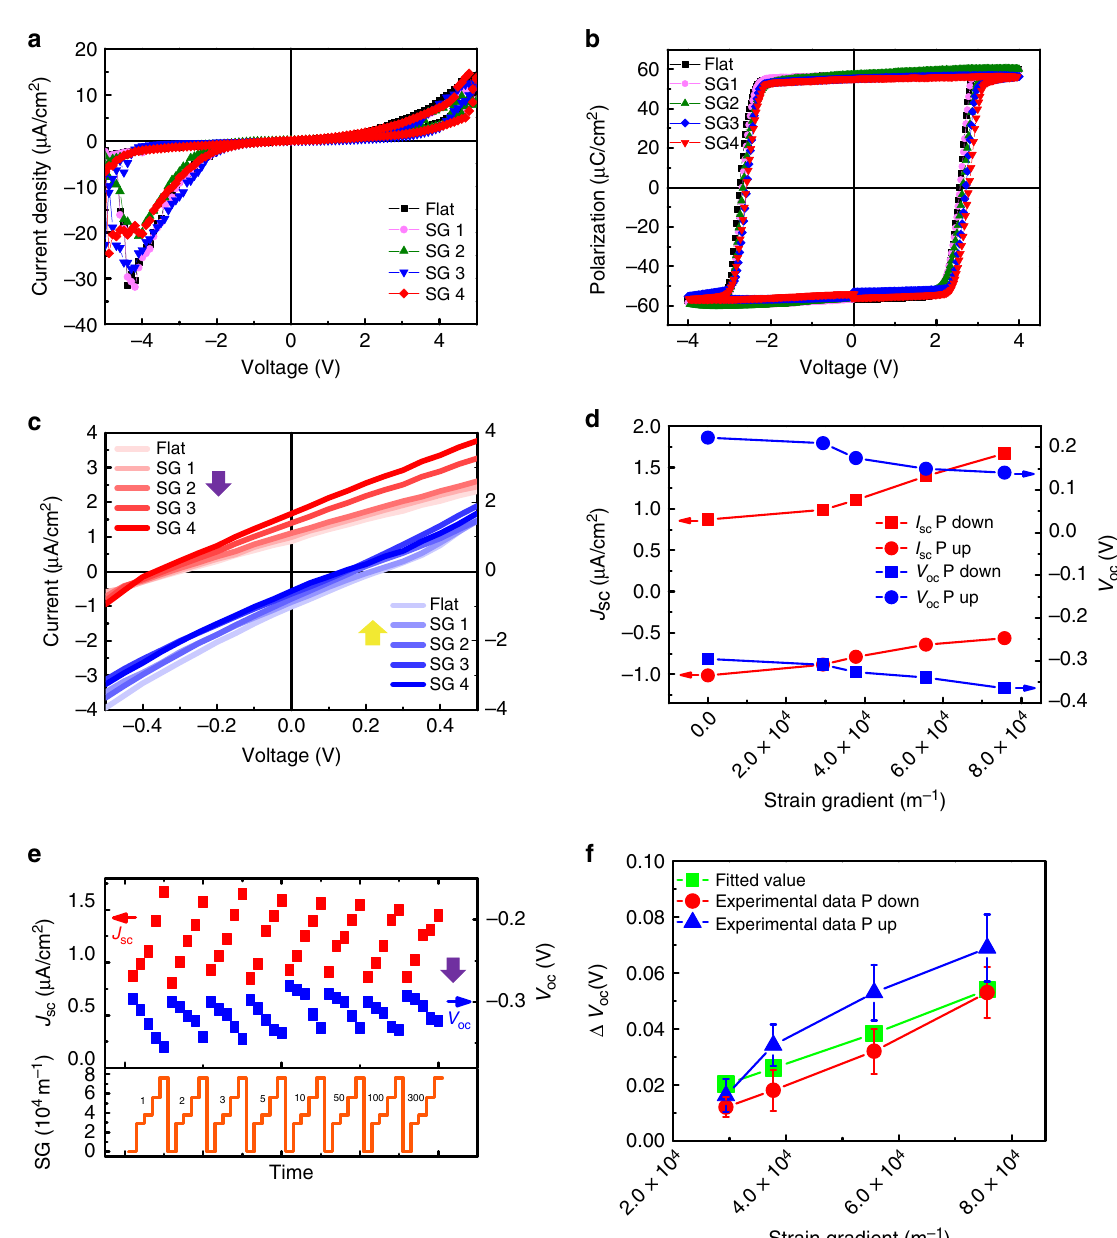
Fig. 4 Bending-tunable photovoltaic properties of freestanding Pt/BFO/LSMO. a J – V switching loops in dark of the freestanding photovoltaic cells with different bending status. b P – V loops of the fl exible device as a function of the strain gradient. c J – V curves under light illumination for both polarizations (with light intensity of 20 mW/cm 2 ) of the fl exible devices with different bending radius. Red curves: polarization downward; blue curves: polarization upward. d The corresponding change of V oc and J sc as function of the introduced in-plane strain gradient for both polarizations. e The change of the V oc and J sc with the function of the introduced in-plane strain gradient (SG) after different bending cycles. The polarization of BFO is downward. f The experimental data of Δ V oc with both upward and downward polarization directions, and the fi tted Δ V oc as the function of the strain gradient by using the value of 0.5 for scaling factor λ . SG1 to SG4 corresponds to the increasing strain gradients of four different bending radii in Fig. 1b. The purple and yellow arrows in c and e represent the downward and upward polarization of BFO. The error bars in f are calculated from multiple measurement results in e and Supplementary Fig.